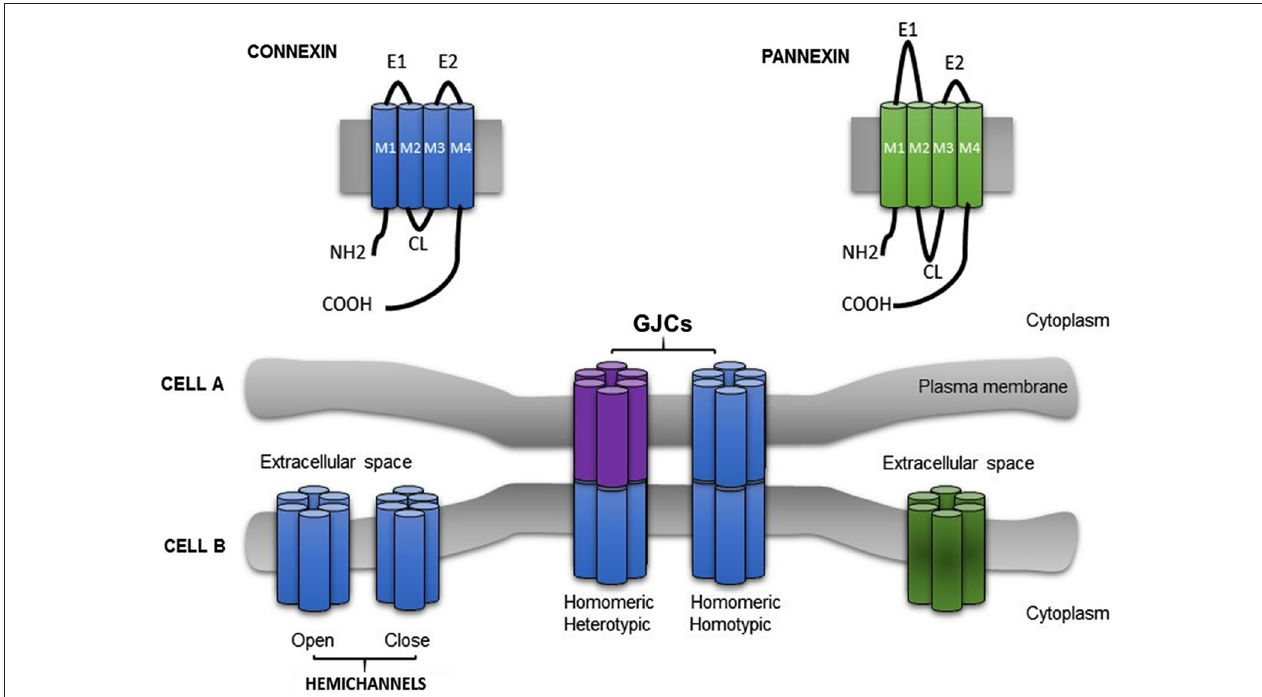
hemichannel. Under physiological circumstances, hemichannel remain closed. Gap junction channels (GJCs) (homotypic or heterotypic) connect the cytoplasm of two adyacent cells (Cell A and Cell B), allowing the passage of a variety of small molecules. Pannexin showed a similar topological